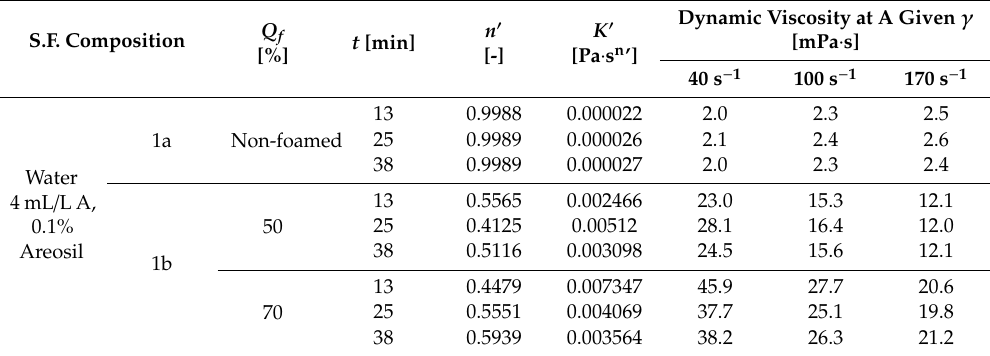
Figure 1. Measuring system to study the damage to the core by fracturing fluids with addition of N 2 / CO 2 gases. Table1. RheologicalparametersoffluidsenergizedwithN 2 withtheapplicationofAerosilnanoadditive, foam quality of 50% and 70%.